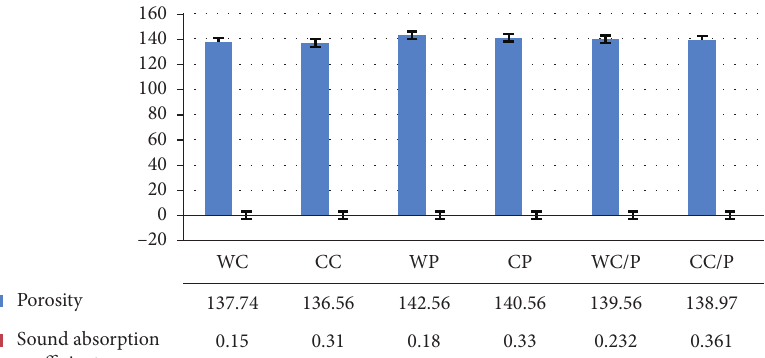
Figure 8: Influence of porosity on sound absorption